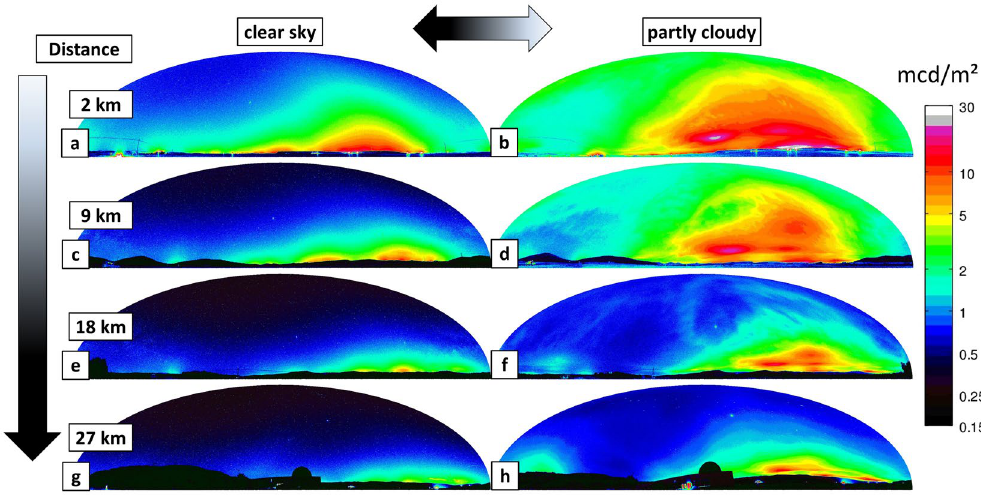
Figure 1. Luminance maps of the night sky in Hammer–Aitoff equal area projection calculated from all-sky images obtained. along the transects from the town of Balaguer towards Montsec Astronomical Park in May 2016. The left column ( a , c , e , g ) shows data obtained on the night of May 3rd/May 4th with a clear sky and the right column ( b , d , f , h ) shows data obtained atthe night of May 5th/May 6th with partly cloudy sky. The upper row ( a , b ) was acquired at 2 km distance, the second row ( c , d ) at 8.5 km distance, the third row ( e , f ) at 17.7 km distance to the city center of Balaguer. The lower row was obtained at the Astronomical Park of Montsec at 27 km distance to Balaguer. The full data set is shown in the Appendix.